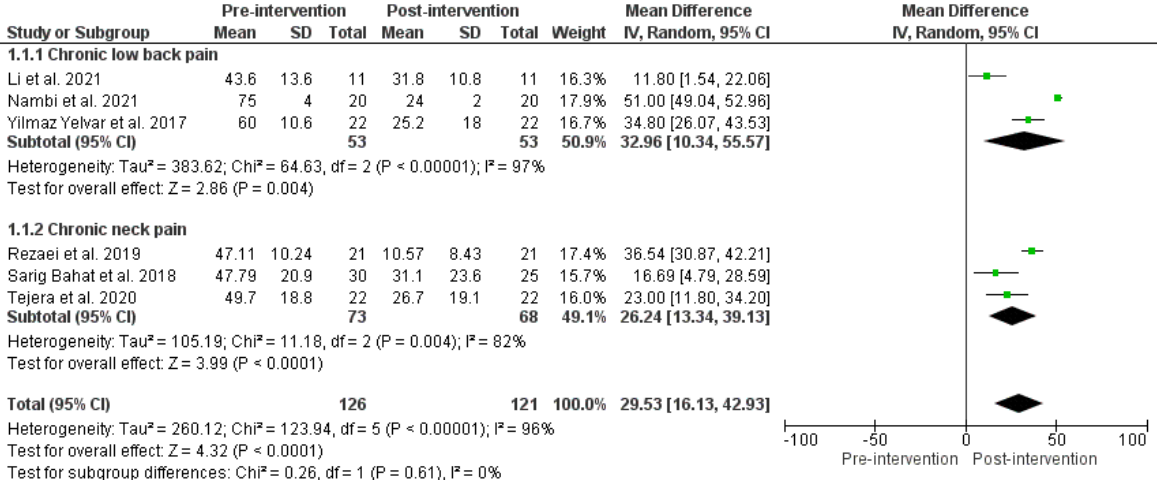
Figure 3. Effects of VR therapy and control on VAS score. Green squares represent mean differ ‐ ence for each study, while black rhombus represents the aggregated average of the mean differ ‐ ences.